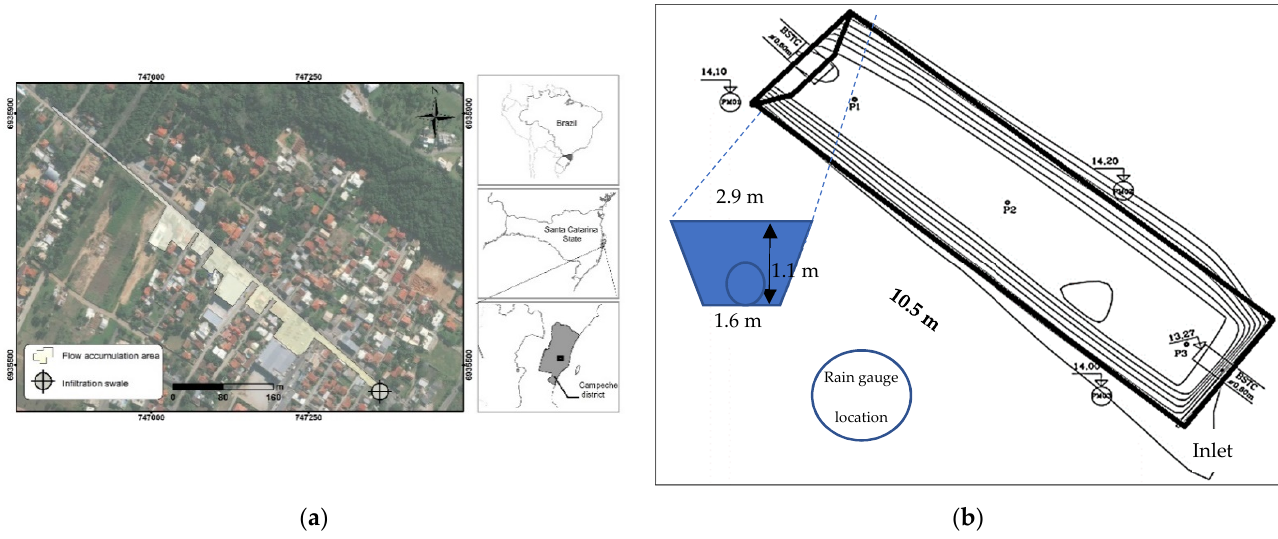
Figure 1. ( a ) Contribution area and location of infiltration swale ( b ) swale instrumentation.